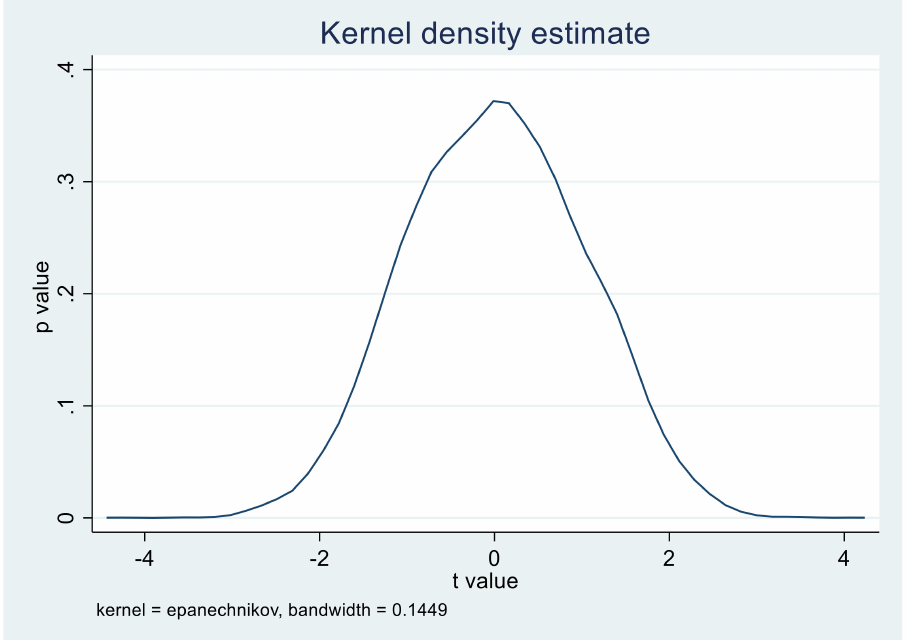
Figure 2. The panel OLS estimation graph of the policy estimation coefficient of 10,000 random sampling experiment panels with a bandwidth of 0.1449.